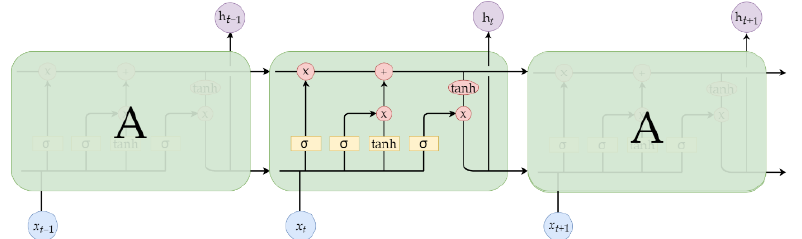
Figure 3. LSTM module diagram .